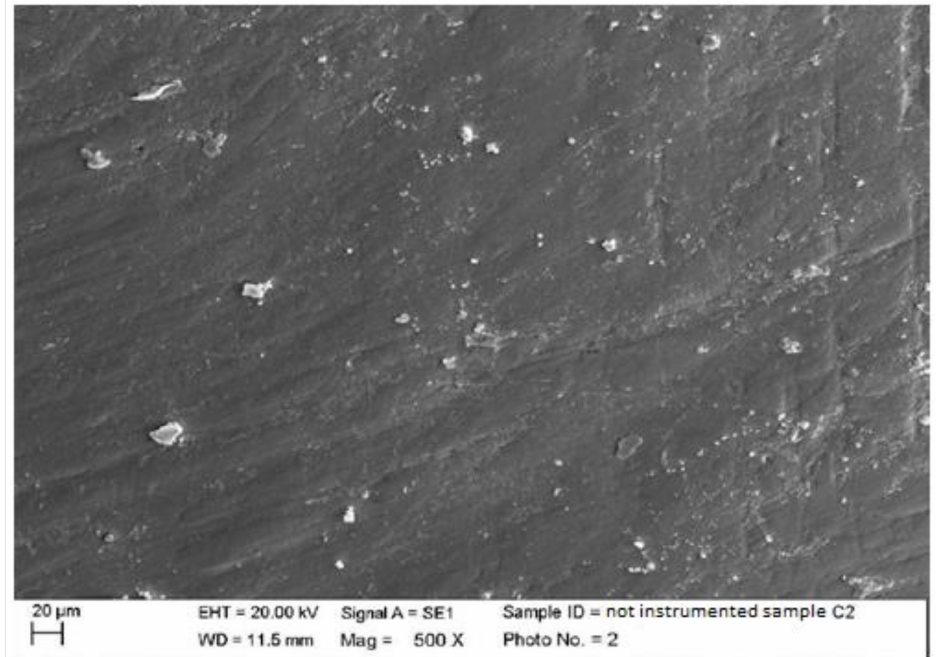
Figure 2. Non-instrumented composite sample C2 (500 ×